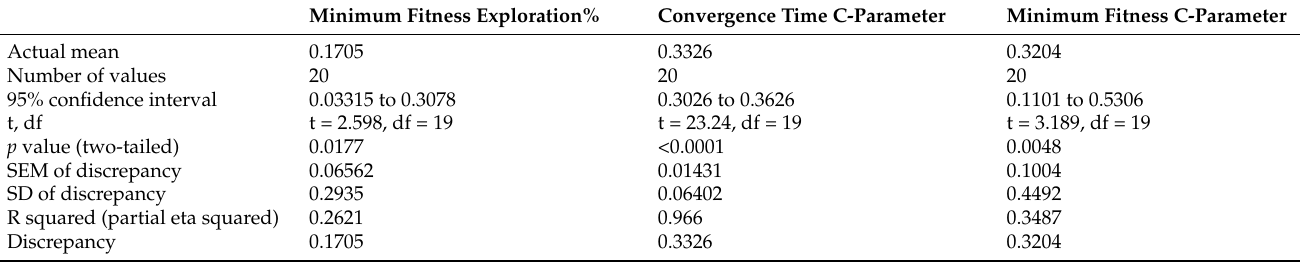
Table 12. Statistical analysis of the results achieved by sensitivity analysis of DTO parameters, part